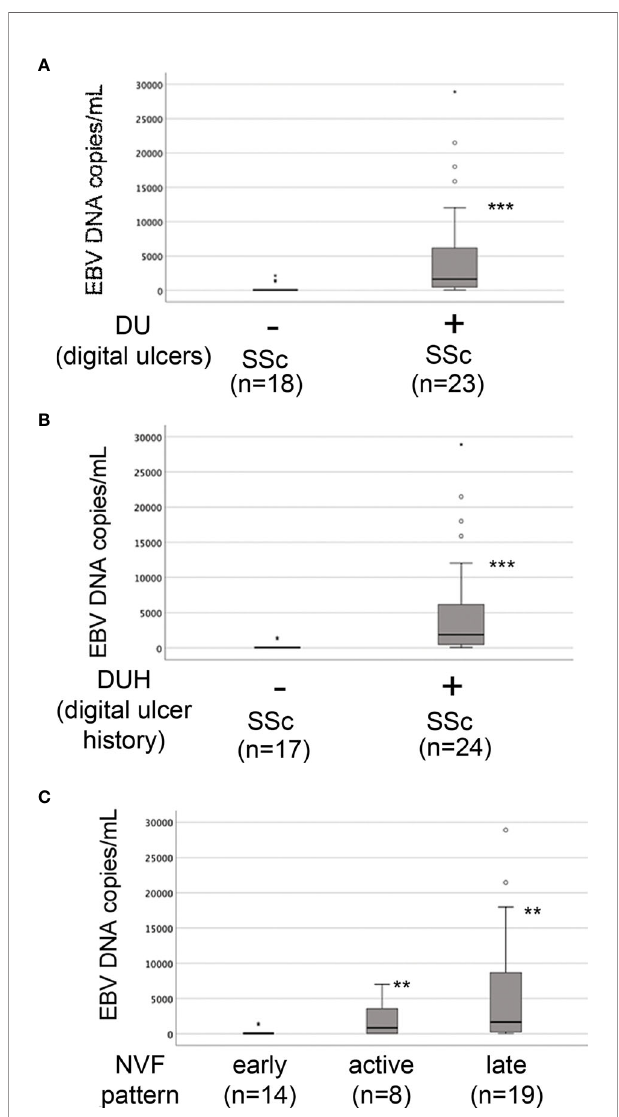
FIGURE 8 | Increased EBV loads correlate with an increased number of digital ulcers and patterns of microvascular damage in SSc. EBV DNA was extracted from whole blood and quanti fi ed by qPCR. EBV quantitative curve was generated using ABI`s Viral load control. qPCR analysis was performed using primers and probe designated to ampli fi ed the EBV polymerase BALF5, and measured using SYBR Green chemistry. Shown here are copies of viral DNA calculated by standard curve. (A, B) SSc patients with active digital ulcers and past history of digital ulcers showing higher level of EBV DNA loads compared to SSc patients with no or fewer digital ulcers showing low or undetectable level of EBV DNA loads. (C) SSc patients with increased